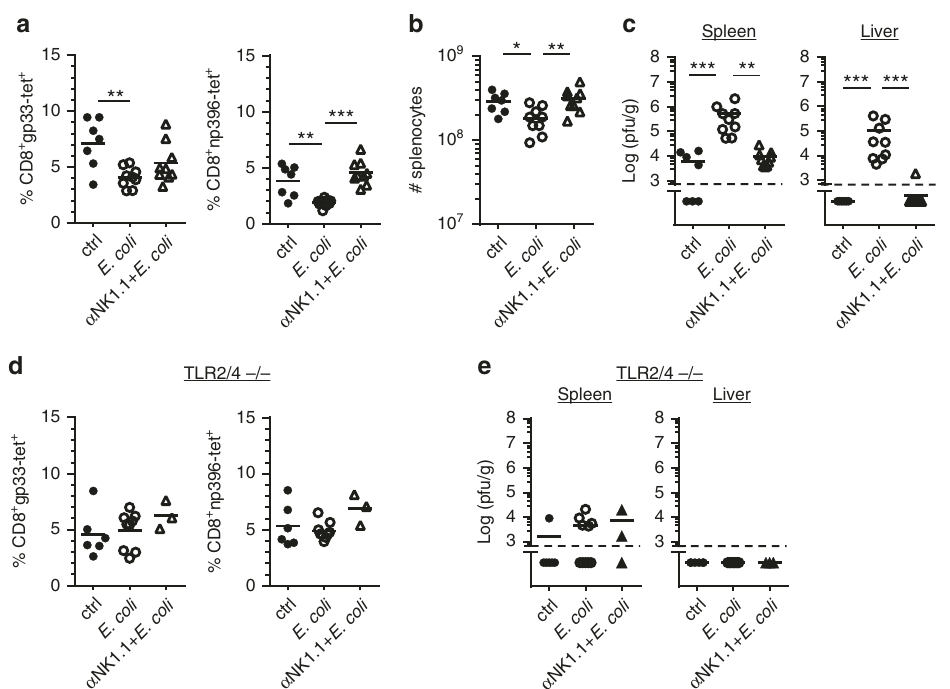
Fig. 1 E. coli coinfection leads to NK cell-mediated impairment of the anti-LCMV CTL response. NK cell-depleted and non-depleted B6 ( a – c ) or TLR2/4- de fi cient mice ( d , e ) were infected with LCMV. One day later, they were coinfected with E. coli or received sterile LB medium as control (ctrl) and were analyzed at day 8 after LCMV infection. a , d gp33- and np396-tetramer + (tet) CD8 T cells in percent of spleen cells. b Absolute numbers (#) of splenocytes. c , e Viral titers in spleen and liver. Data of individual mice ( n = 7 – 9 ( a – c ), n = 3 – 9 ( d , e )) from 1 – 3 independent experiments with 2 – 4 mice per group are shown; horizontal bars represent the mean values. Dashed lines indicate detection limits. * p < 0.05, ** p < 0.01, *** p < 0.001; one-way ANOVA with Tukey-Kramer post-test ( a , b ), Mann – Whitney ( d , e ), or Kruskal – Wallis Test with Dunn ’ s post-test ( c )